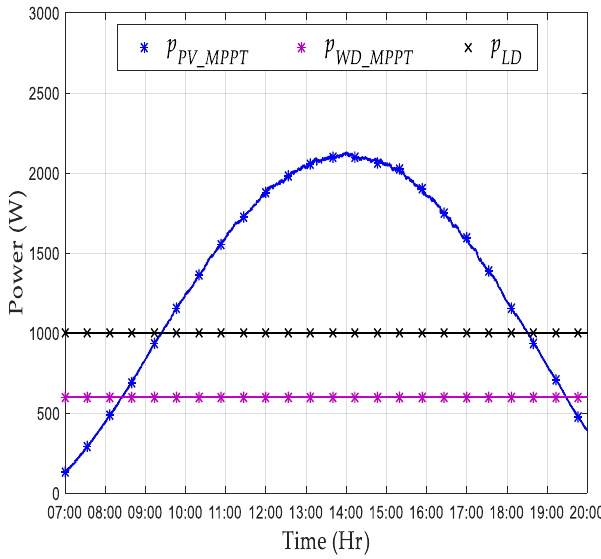
Figure 4. Power profile proposed arbitrary.